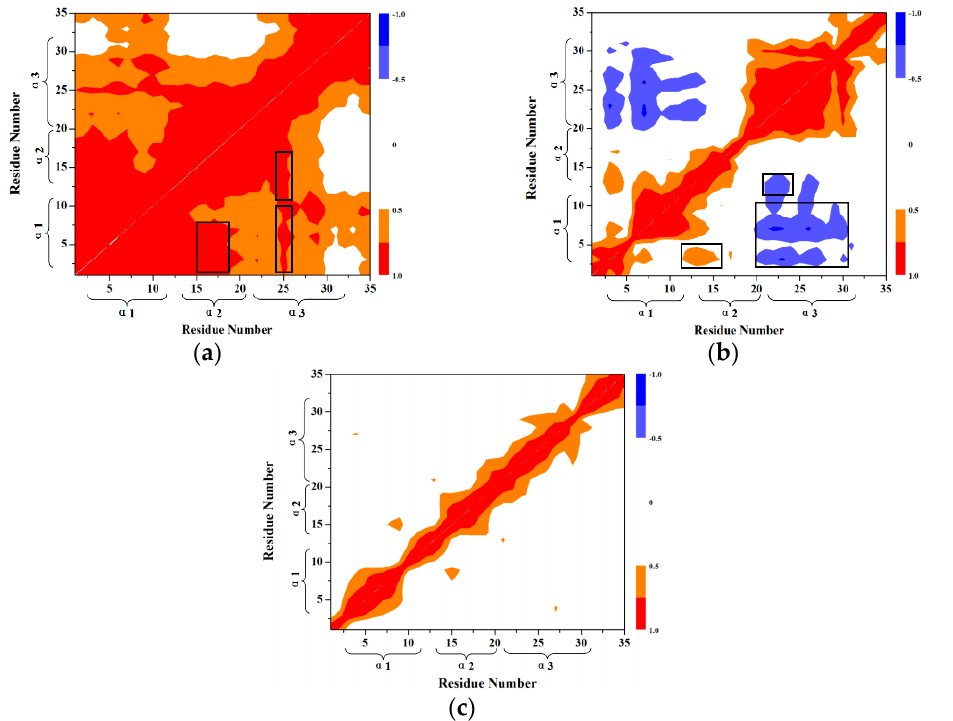
Figure 9. Dynamical cross-correlation maps for ( a ) HP35-R model; ( b ) HP35-L model; ( c ) B conformation with the key sub-regions squared in black. Table 2. Occupancies (%) of hydrogen bonds for the HP35-R, B, D and HP35-L conformations.